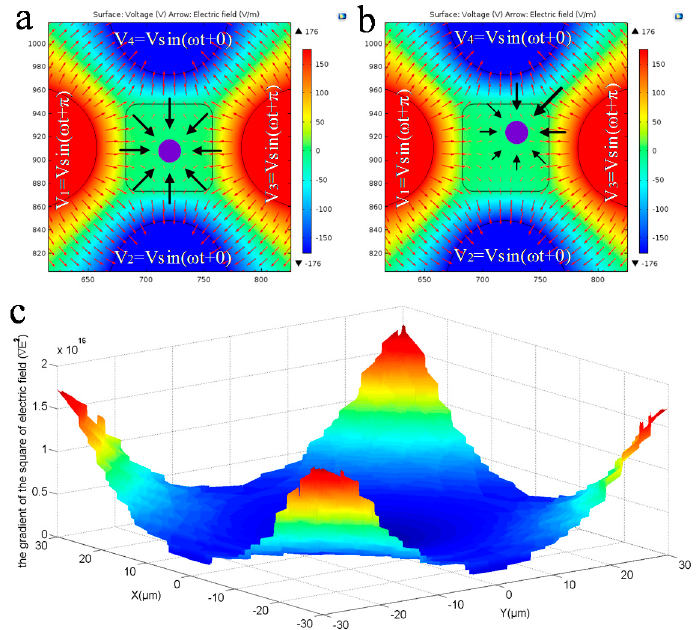
Figure 5. Trapping a cell in the central region of the electrode chamber. ( a ) The top view of the electric field distribution of the electrode chamber and the cell is in a balanced state. ( b ) The cell deviates from the balanced position, and the resultant force is not zero. ( c ) The distribution of the gradient of the square of the electric field in the electrode chamber.